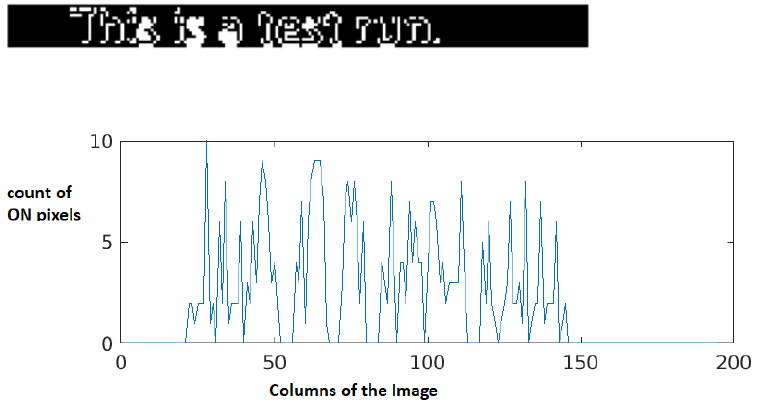
Figure 4. Vertical Histogram